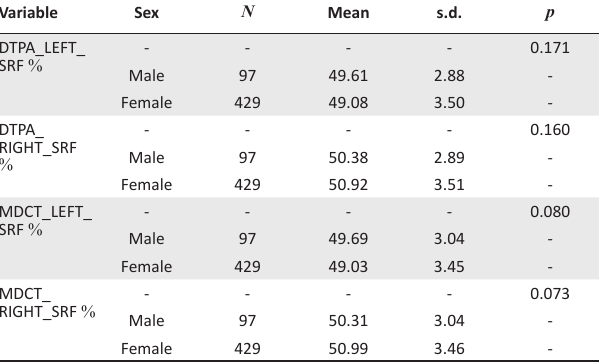
TABLE 3 : Comparison of split renal function between diethylenetriaminepentaacetic acid and multidetector computed tomography. Variable